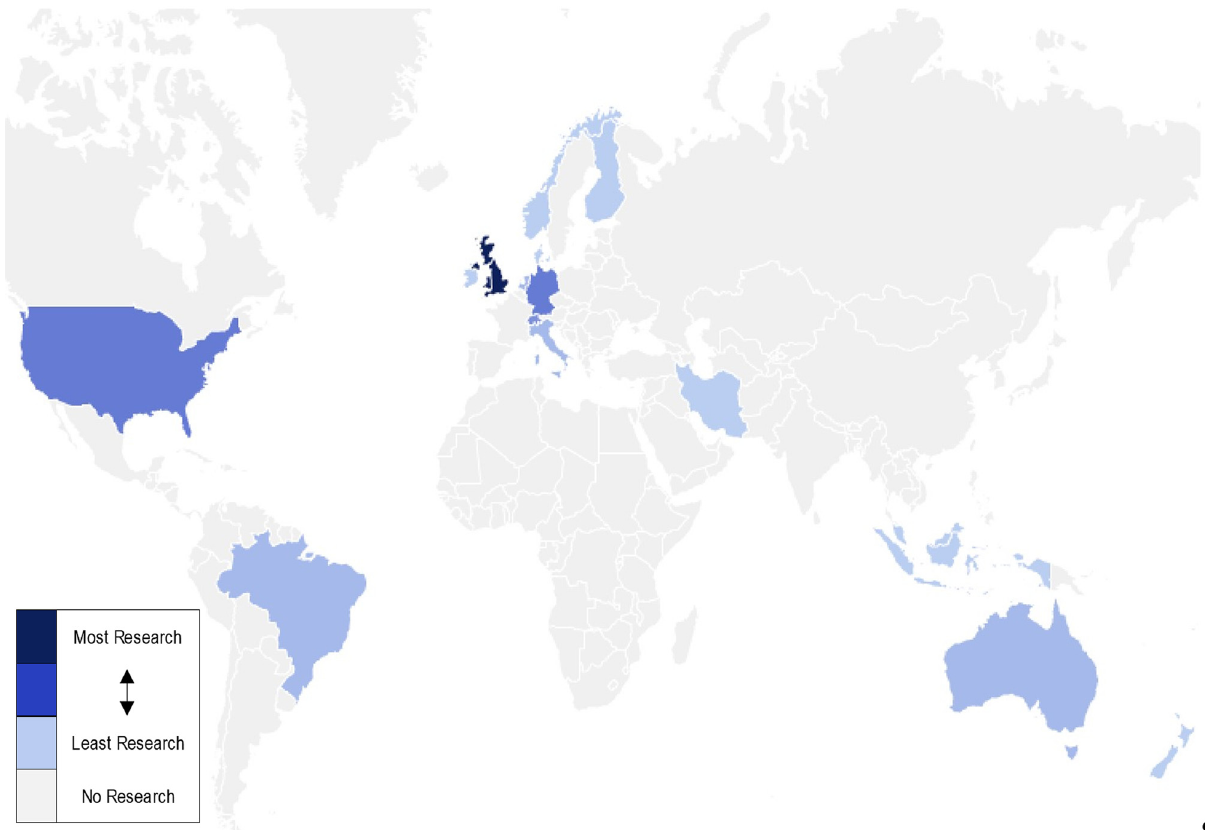
Figure 2: Global research status of sex robots ( Scopus ) .